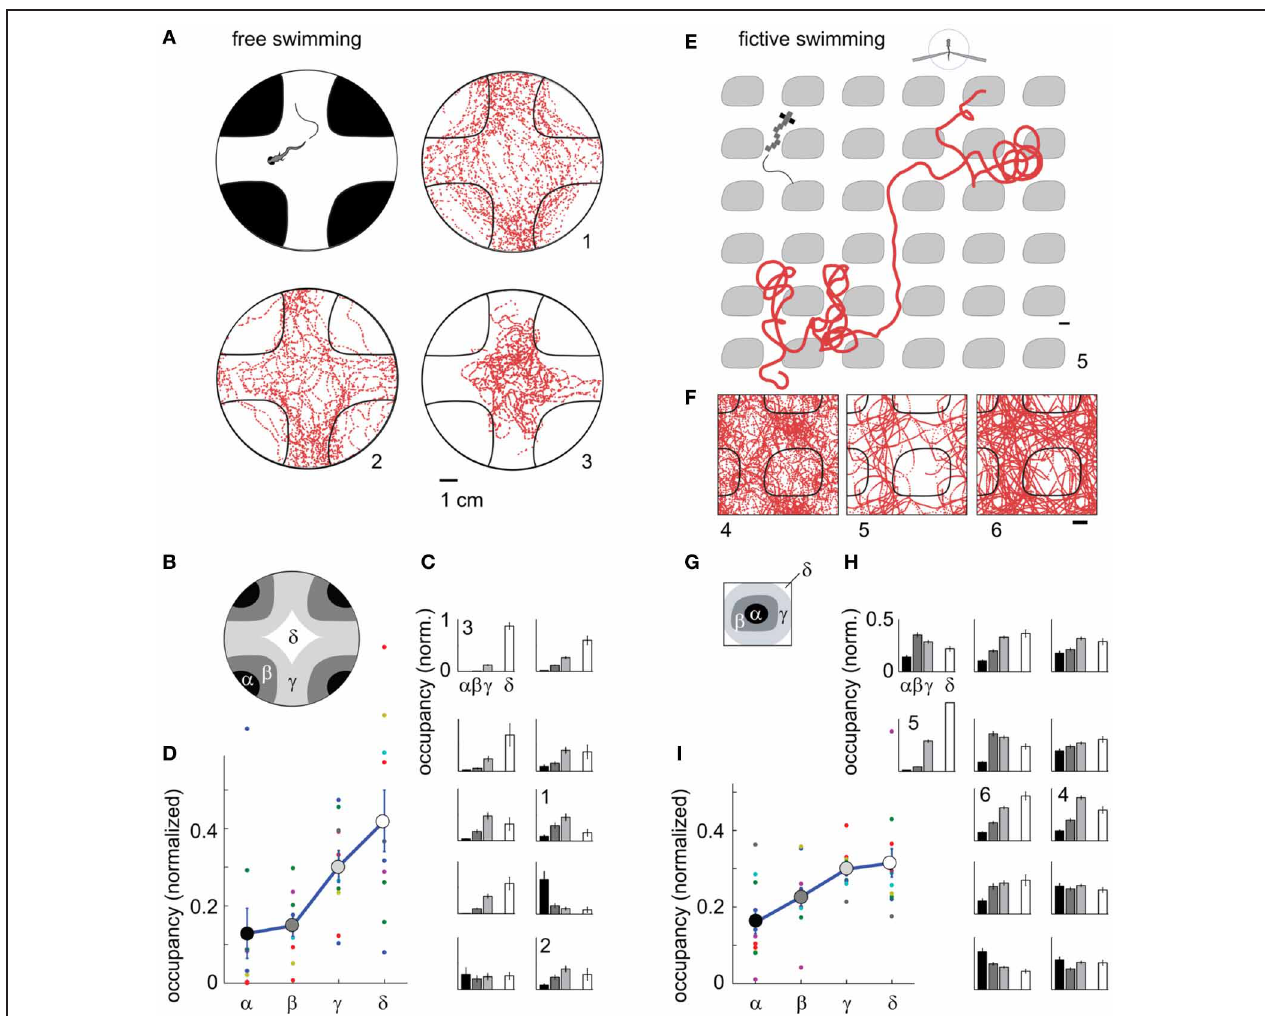
FIGURE 6 | Darkness avoidance in free and paralyzed fish. (A) Top view schematic of the arena, consisting of a 10cm petri dish on top of a visual display. Display color was red to replicate the color used during two-photon imaging. Shown are trajectories of 3 fish over 20min of experimental time (labeled 1–3). On average, fish spend more time in the bright region. (B) Subdivisions α − δ of the arena used for further analysis of location preference. (C) Time spent in the areas α − δ ( N = 10 fish). Eight fish preferentially stay in the bright region; one fish spends more time in the dark region; one fish does not distinguish. Error bars computed from Bernoulli distribution over counts, then normalized to the area of the four regions. (D) Average normalized occupancy of regions α − δ ( N = 10 fish) shows a strong